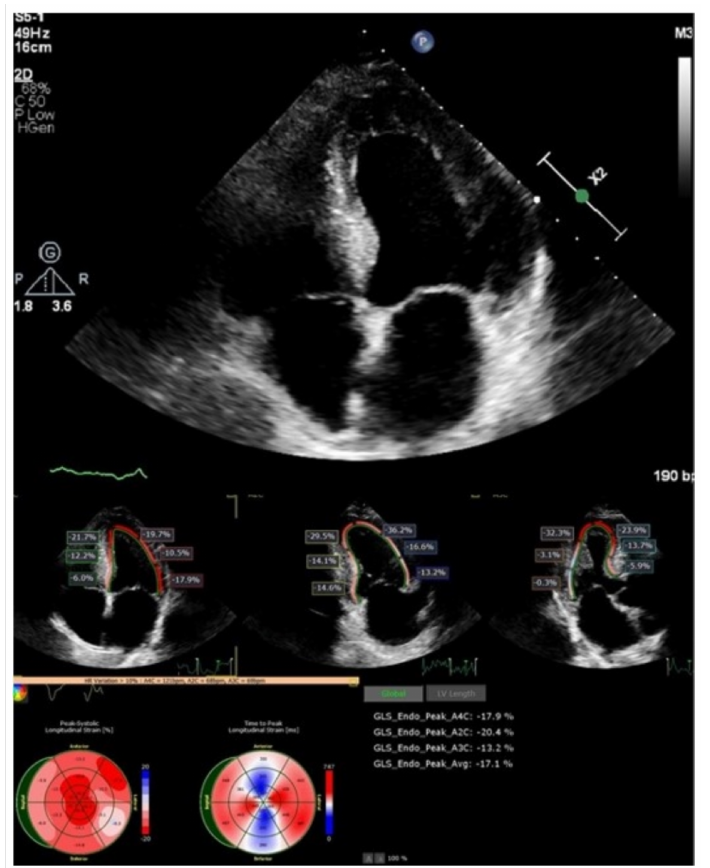
Figure 3. Two-dimensional echocardiography and speckle tracking: LV hypertrophy with maintained strain in apical LV segments.